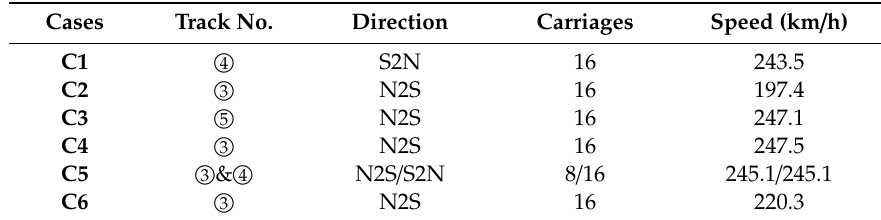
Table 5. Loading cases of view S3.